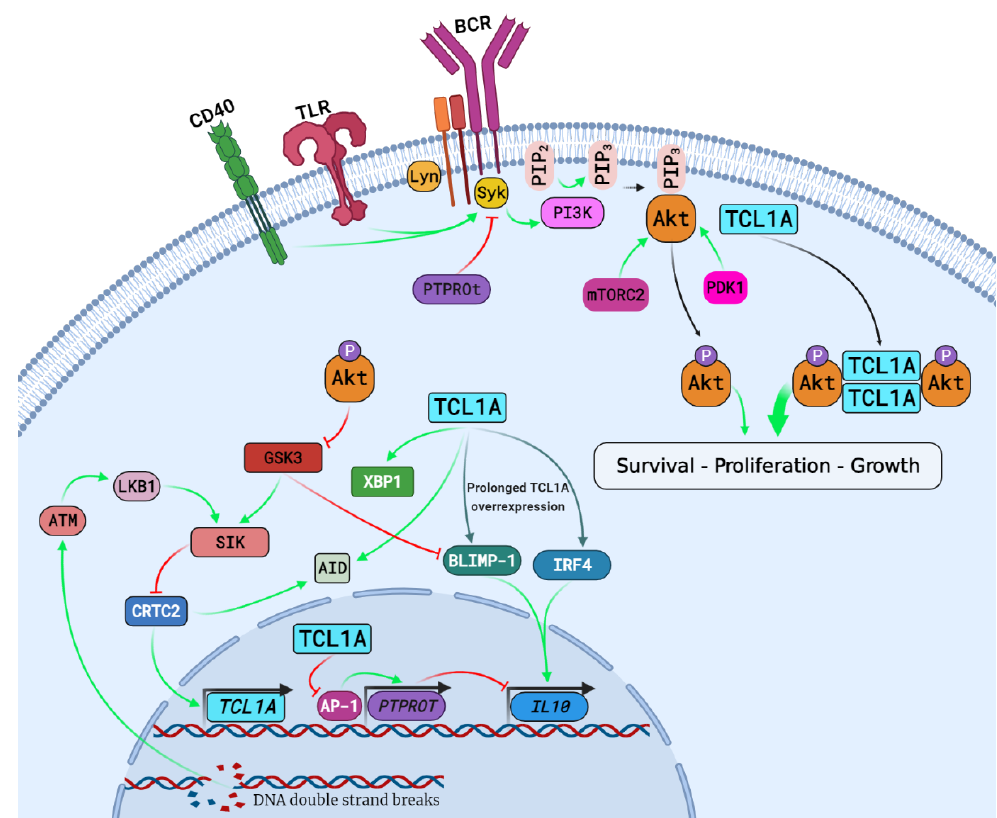
Figure 1. Schematic representation of TCL1A interactions in B cells. Stimulation of surface B cells’ receptors (CD40, TLR, BCR) induces a phosphorylation cascade implying, notably, Lyn and Syk enzymes leading to PI3K activation. PI3K converts PIP2 into PIP3, allowing Akt recruitment to the membrane and its full activation by mTORC2 and PDK1. Once phosphorylated, Akt activates downstream targets leading to B cell survival, growth, and proliferation. TCL1A homodimers complex with Akt allowing to increase its effects by favoring its phosphorylated state and its translocation to the nucleus. During GC transformations, AID generates DNA double stand breaks inducing CRTC2 inactivation by SIK through ATM and LKB1 leading to AID and TCL1A downregulation. TCL1A overexpression could lead to XBP1 and AID upregulation and in the long term of BLIMP-1 and IRF4, both transcription factors involved in B cell differentiation and IL-10 expression. TCL1A also impairs PTPROt expression through AP-1 inhibition while PTPROt downregulation increase IL-10 expression. Phosphorylated Akt also inactivate GSK3 which favors IL-10 expression through BLIMP-1. Created with BioRender.com (accessed on 20 May